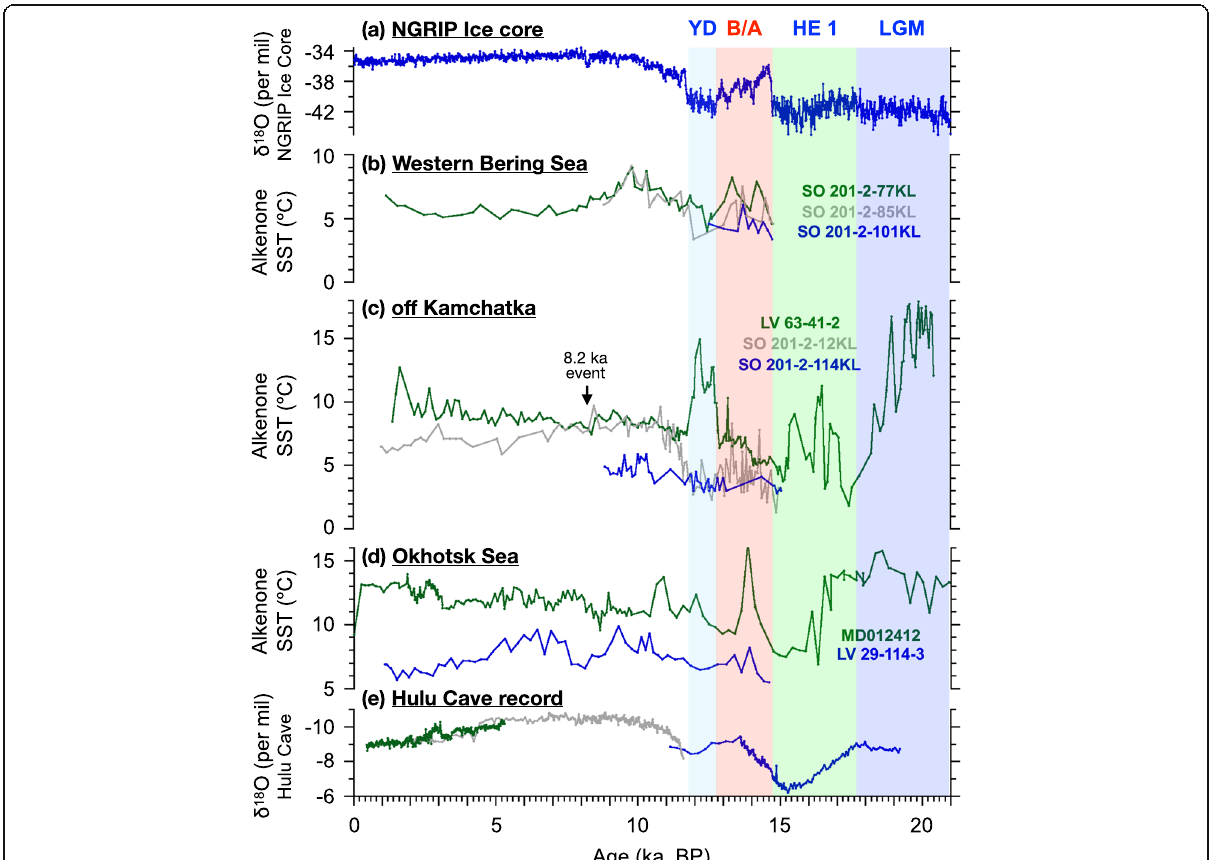
Fig. 4 Last glacial subarctic NW Pacific alkenone-SST changes and its linkage with high-to-low latitude climate variability. a Northern Atlantic climate variability represented by NGRIP ice core δ 18 O sequence (GICC05; North Greenland Ice Core Project members 2004); b western Bering Sea alkenone-SST records: SO 201-2-101KL, SO 201-2-85KL, and SO 201-2-77KL (Max et al. 2012); c off Kamchatka alkenone-SST records: SO 201-2- 114KL, SO 201-2-12KL, and LV 63-41-2 (Max et al. 2012; This study); d the Okhotsk Sea alkenone-SST records: LV 29-114-3 and MD012412 (Max et al. 2012); and e East Asian monsoon climate variability represented by the Hulu cave δ 18 O sequence (Wang et al. 2004). Shaded intervals indicate LGM, HE 1, B/A, and YD. Arrow shows the 8.2 ka cooling